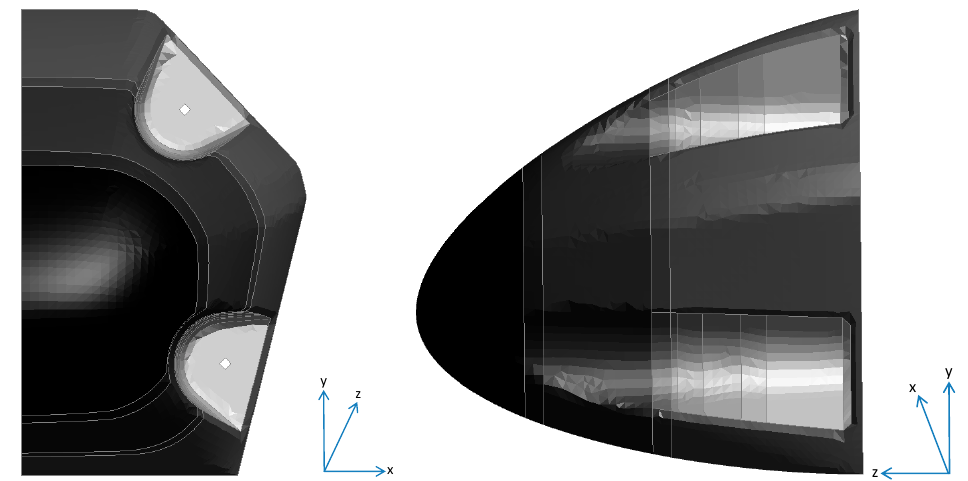
Figure 2. Boundary conditions applied in CFRP nose cone model.